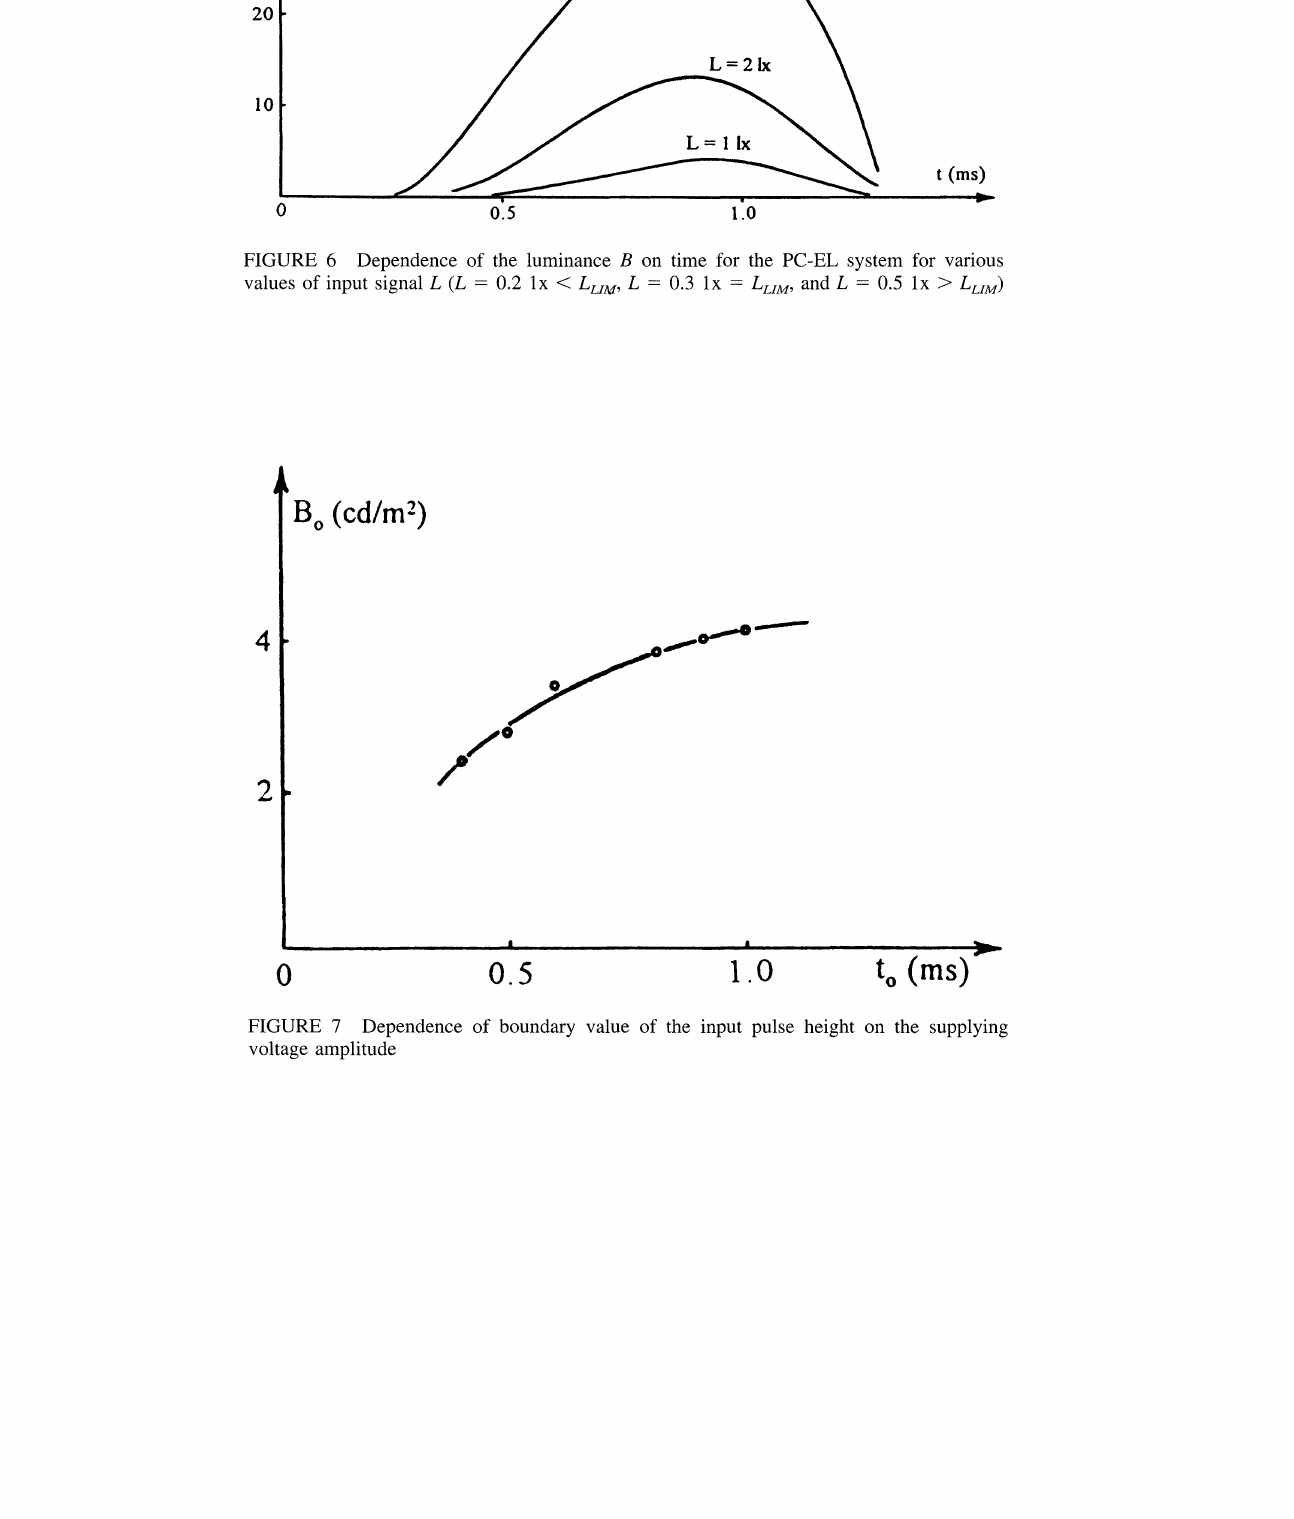
FIGURE 6 Dependence of the luminance B on time for the PC-EL system for various values of input signal L (L